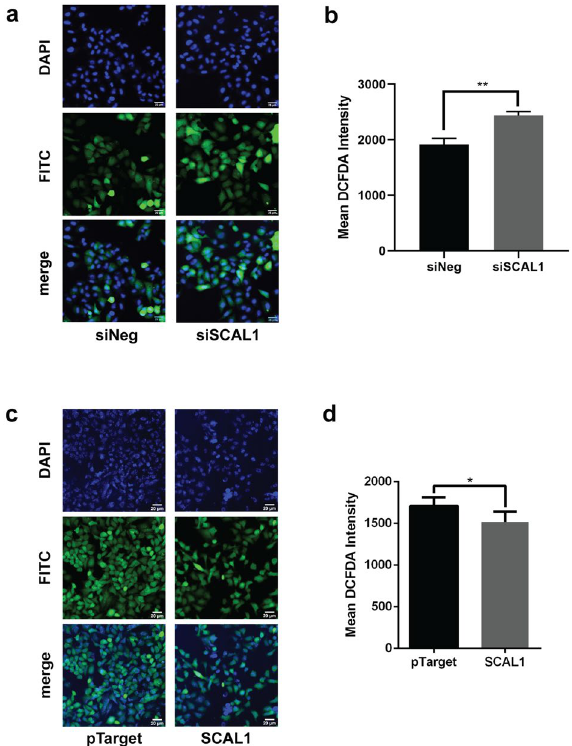
Figure 5. DCFDA staining of CSE-treated, SCAL1-deficient and SCAL1-overexpressing A549 cells to assess production of reactive oxygen species (Olympus IX51, ×100, FITC: 500 ms). ( a , b ) The fluorescein-based dye DCFDA exhibits green fluorescence upon oxidation by ROS. The bright green signal observed in A549 cells signifies ROS production. DCFDA intensities normalized against cell count showed increased mean ROS production upon SCAL1 knockdown. ( c , d ) DCFDA fluorescence signals were lower in the SCAL1 overexpression setup, suggesting that increased SCAL1 levels decrease ROS production. Data presented are representative of three independent trials performed in triplicates and are expressed as the mean ± SD. *P < 0.05, **P < 0.01, ***P < 0.001 and ****P <